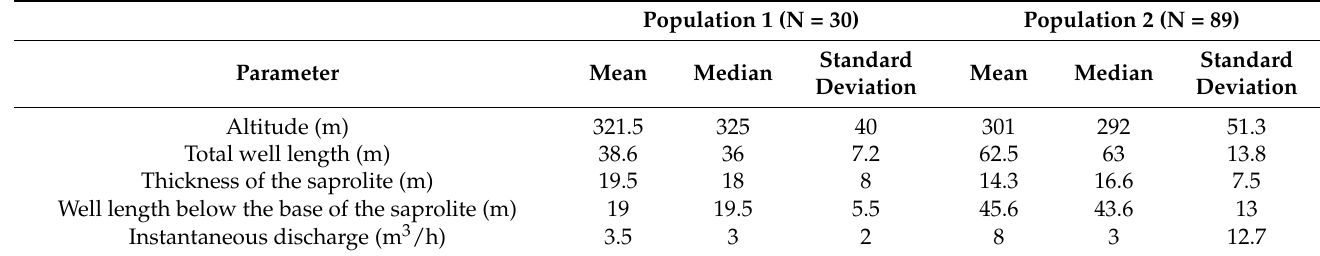
Table 7. Statistical parameters in the Biotite granodiorite and Biotite metagranodiorite.